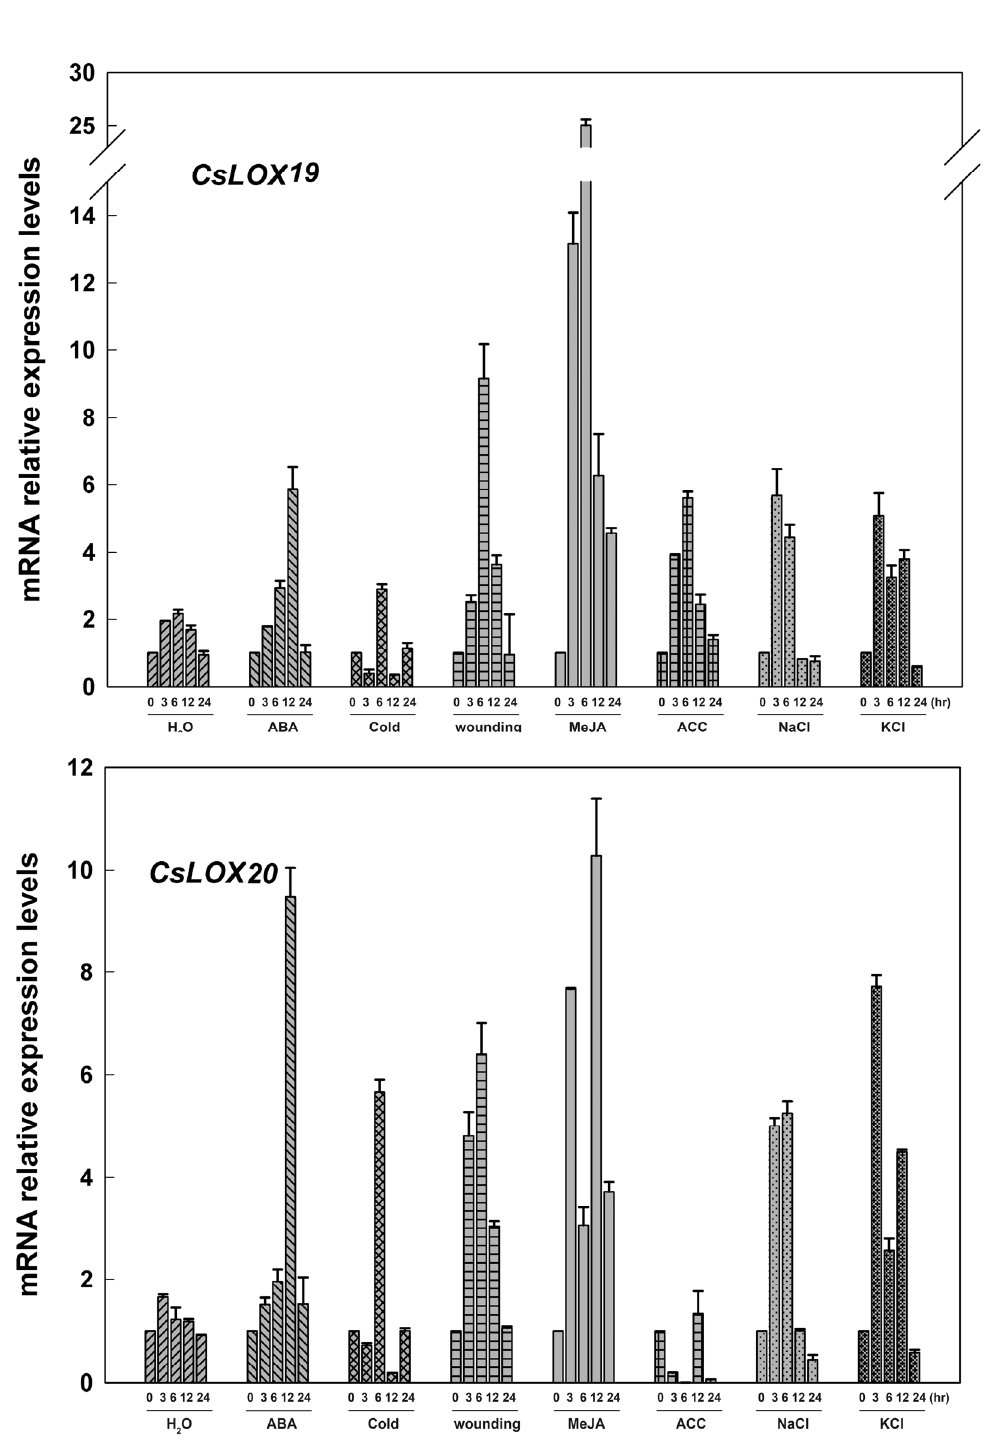
Figure 8. Expressions of CsLOX19 and CsLOX20 in cucumber leaves at various time points under treatments with H O, ABA (100 μ M), cold (4 °C), wounding, MeJA (100 μ M), ACC 2 (100 μ M) NaCl (200 mM) and KCl (200 mM) were analyzed by Real-time PCR. A cucumber actin gene CsACT (Csa017310) was detected as internal reference. Data represent the mean ± SD of three independent biological